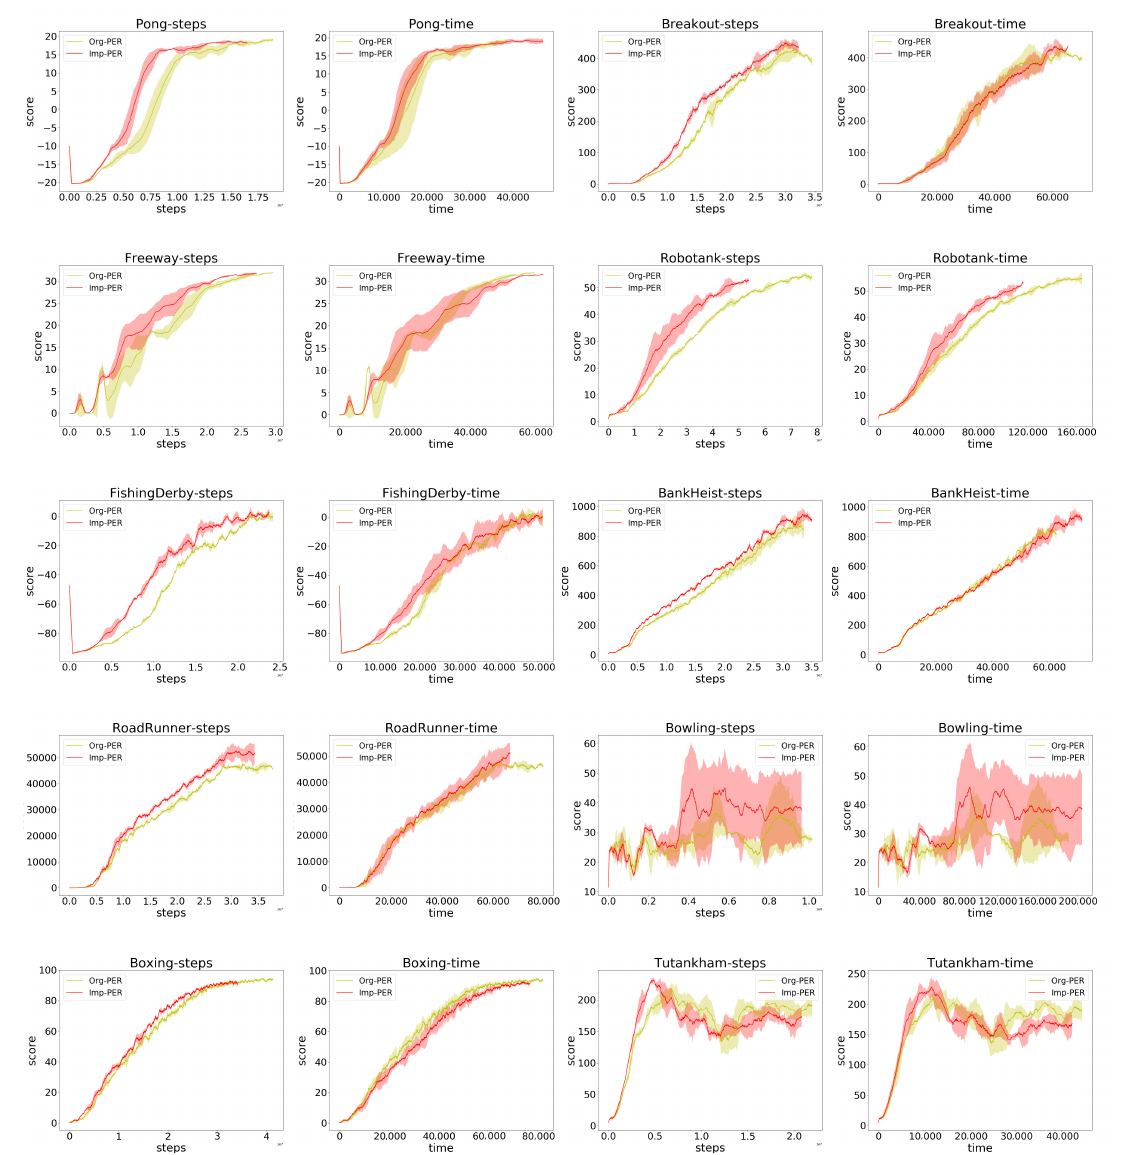
Figure 12. The performance compared to other games. Each task is trained with five different random seeds. The shaded area shows the standard deviation. The first column and third columns are data utilization on each game. Correspondingly, the second and fourth columns are time spent on each